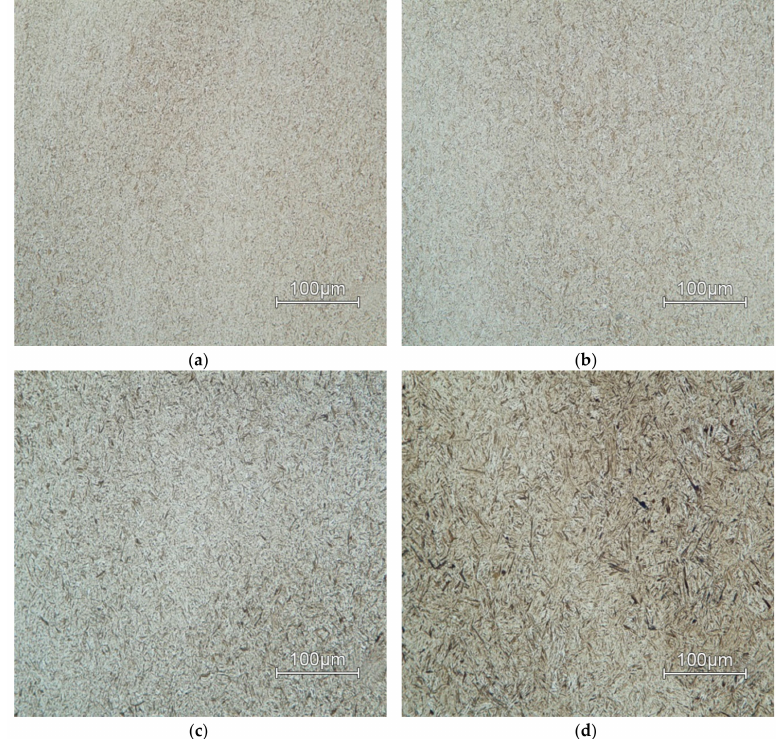
Figure 17. Microstructure of samples deformed at temperature of T = 900 ◦ C at strain rate: ( a ) 1 s − 1 ; ( b ) 0.1 s − 1 ; ( c ) 0.01 s − 1 ; ( d ) 0.001 s − 1 .